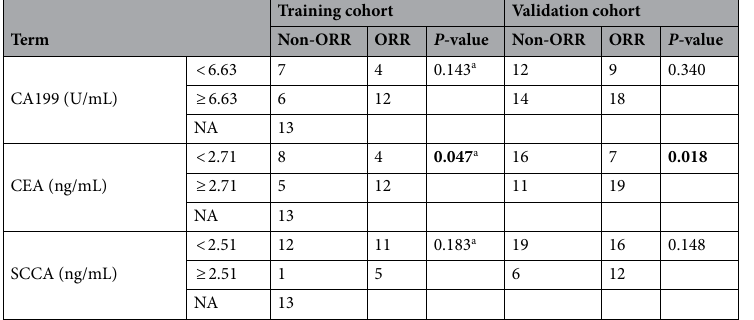
Table 2. Laboratory indicators of esophageal cancer patients received neoadjuvant chemotherapy combined with immunotherapy. a Fisher exact test. ORR, objective response rate; WBC, white blood cell; NLR, neutrophil-to-lymphocytes ratio; PLR, platelet-to-lymphocyte ratio; SII, systemic immune-inflammation index; ALT, alanine aminotransferase; AST, aspartate aminotransferase; FDP, fibrin degradation product; TT, thrombin time; APTT, activated partial thromboplastin time; PT, prothrombin time; CA199, carbohydrate antigen199; CEA, carcinoembryonic antigen; SCCA, squamous cell carcinoma antigen. Significant values are in